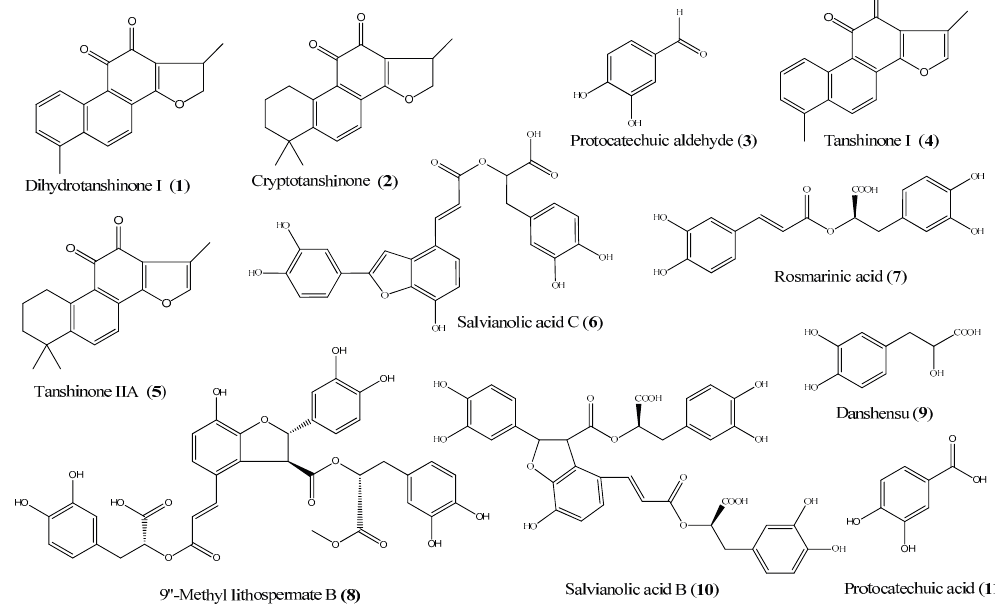
Figure 1. The chemical structures of 11 investigated